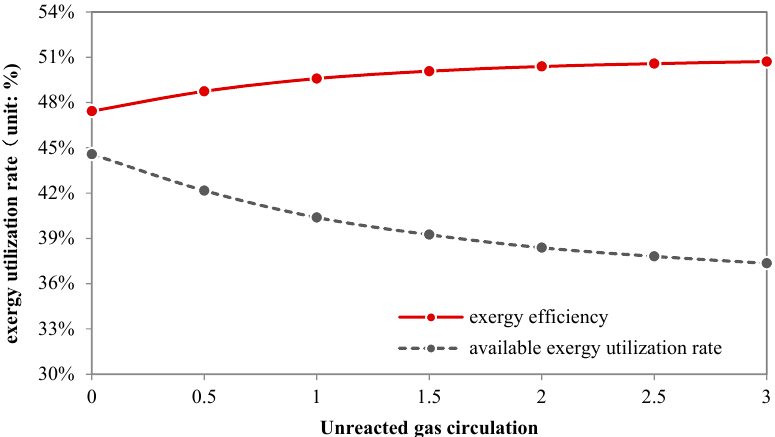
Figure 9. Exergy loss of chemical processes in the no-shift series polygeneration system. Figure 10 illustrates the effect of λ on the overall exergy efficiency and physical ex- ergy efficiency.